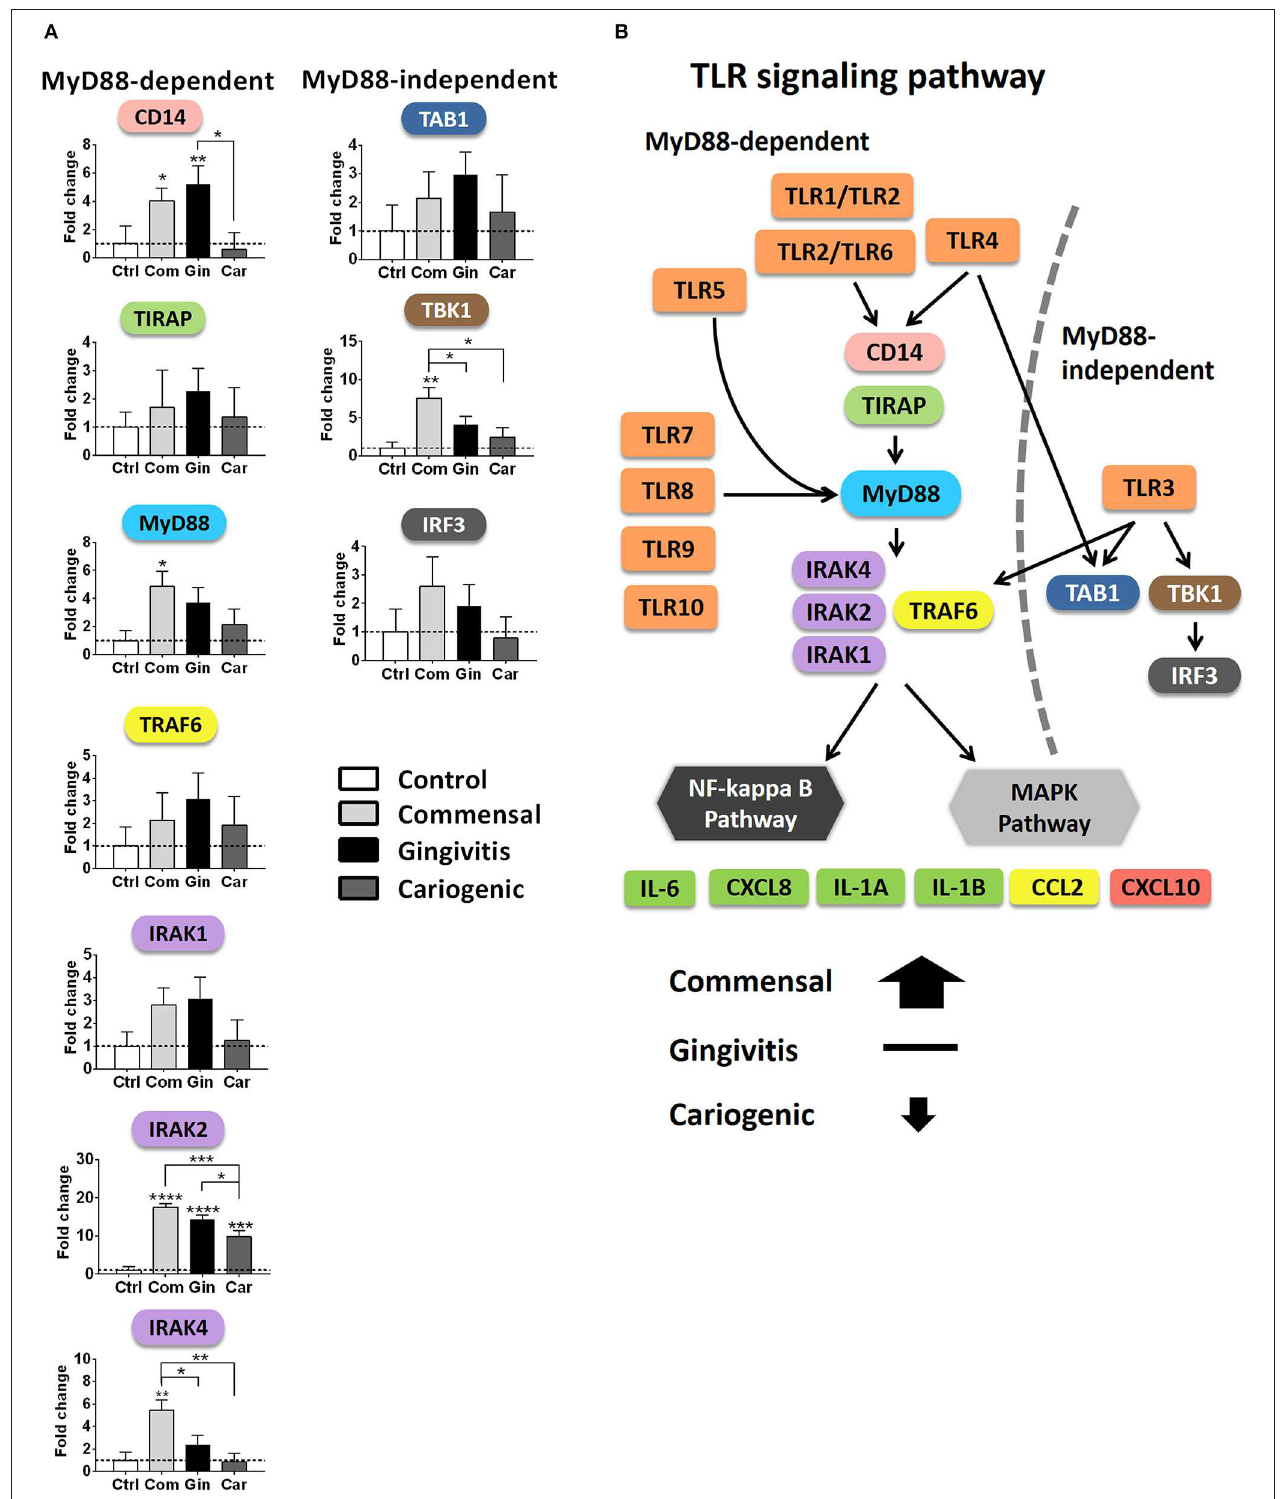
FIGURE 6 | Overview of TLR signaling pathways after biofilm exposure. (A) The mRNA expression of key genes involved in the MyD88-dependent and independent pathways are shown after biofilm exposure. Data represent the average of three independent experiments, each with an intra-experiment duplicate ± SD; * p < 0.05; ** p < 0.01; *** p < 0.001; **** p < 0.0001; one-way ANOVA followed by Bonferroni’s multiple comparison for comparison between groups. (B) Diagram showing TLR signaling pathways summarizing the differential regulation by commensal and pathogenic (gingivitis, cariogenic) biofilm exposure.